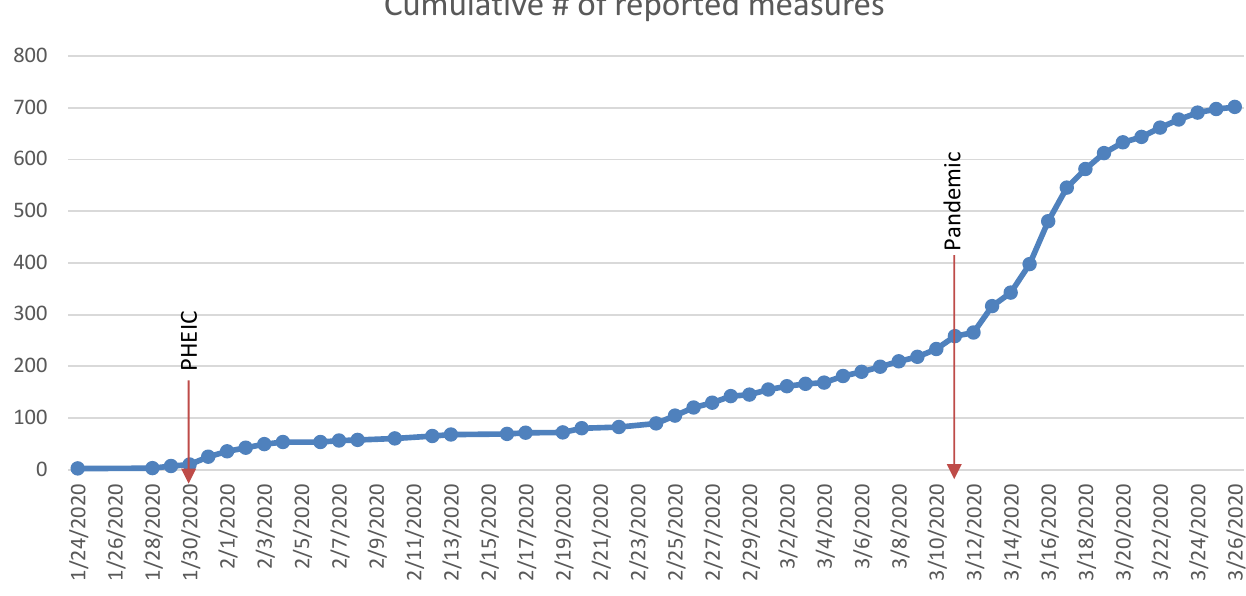
WHO has maintained weekly technical coordination with the aviation and tourism sectors. Interim guidance on the management of ill travellers at Points of Entry was published on 19 March. IATA recently published the third economic analysis, providing estimates of the economic impact of these travel restrictions. On 25 March, the UN World Tourism Organization launched a Crisis Committee, bringing together actors from the aviation, shipping and tourism sectors to review the impact of the outbreak on these sectors and propose innovative solutions for recovery. WHO has a technical advisory role in this